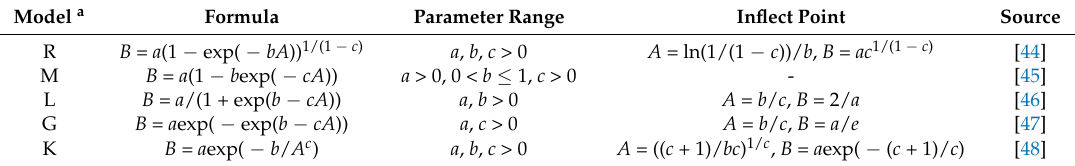
biomass and stand